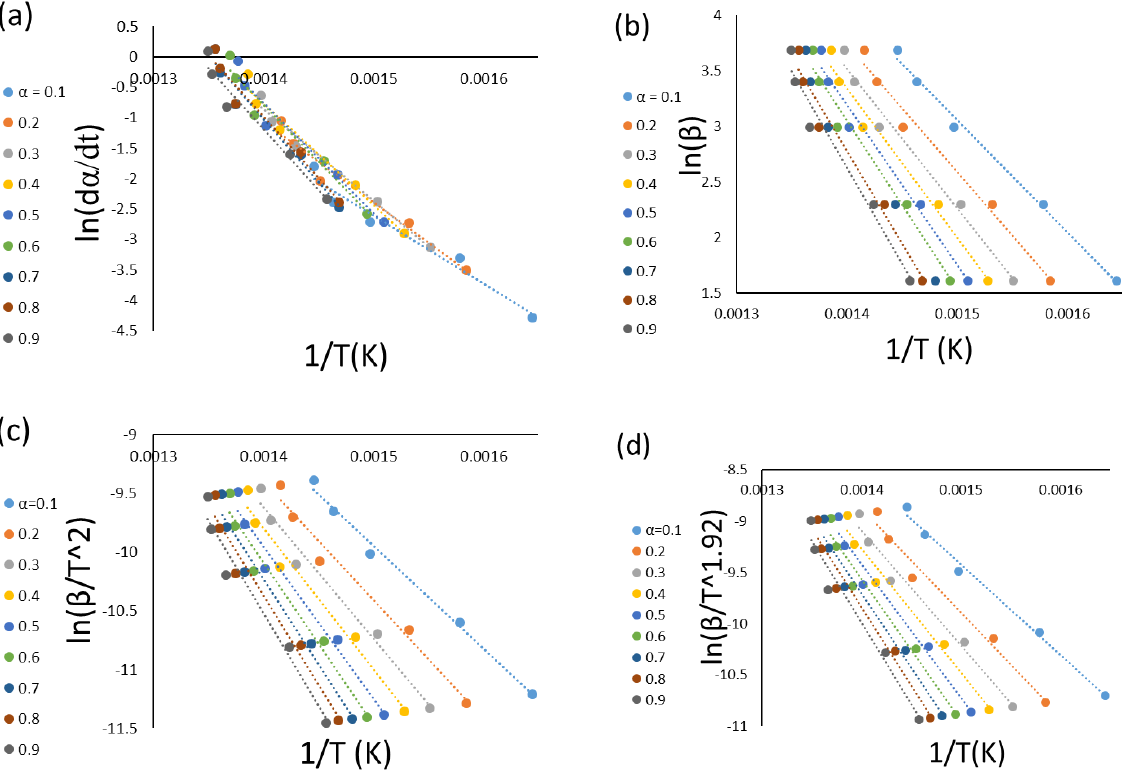
Figure 3. Model-free methods of the PP pyrolysis by the: ( a ) FR, ( b ) FWO, ( c ) KAS, and ( d ) STK models.